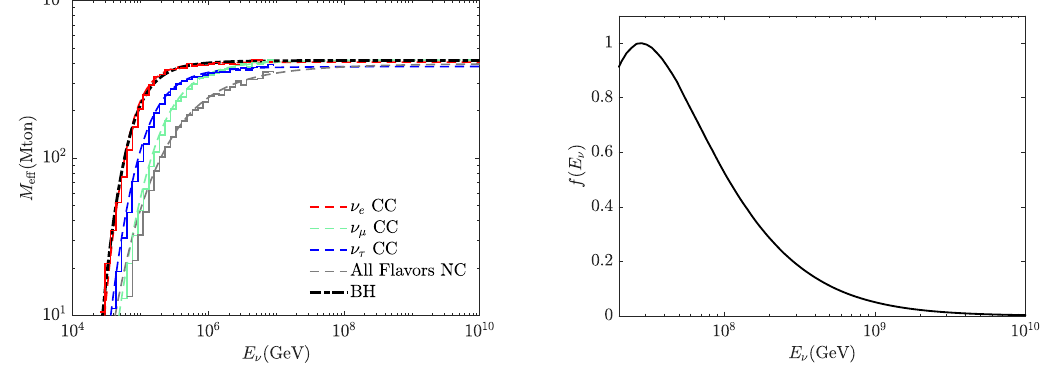
Figure 2 . Left: e(cid:11)ective mass as a function of the incoming neutrino energy for (cid:23) e CC (red), (cid:23) (cid:22) CC (green), (cid:23) (cid:28) CC (blue), NC (gray) and black hole productions (black), for IceCube. In this section we use the same e(cid:14)ciency function, but rescale the overall normalization by a factor of 7.9/0.644 to simulate the larger volume of IceCube-Gen2. The solid lines show the e(cid:11)ective mass from the IceCube collaboration and the dashed lines are obtained from the (cid:12)t. The e(cid:11)ective mass for black hole productions is taken from the M e(cid:11) ( E true ) found in [70]. Right: weighting function f ( E (cid:23) ) which governs the black hole production rate’s dependence on incoming neutrino energy E (cid:23) (see eq. (3.6)). The maximum of the distribution is normalized to 1. In producing results in this